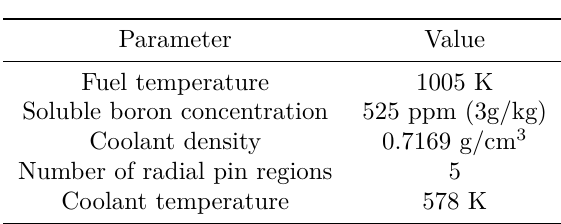
Table 3. Stationary parameters of the Serpent calcu- lation chosen based on standard WWER-1000 opera- tional